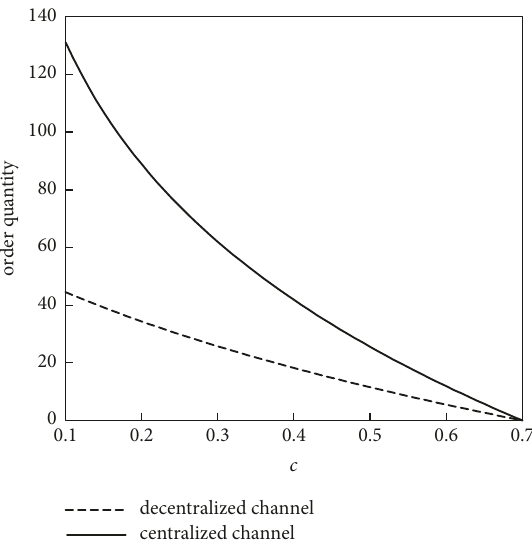
Figure 9: Supply chain’s profitsunder different marginal production costs.